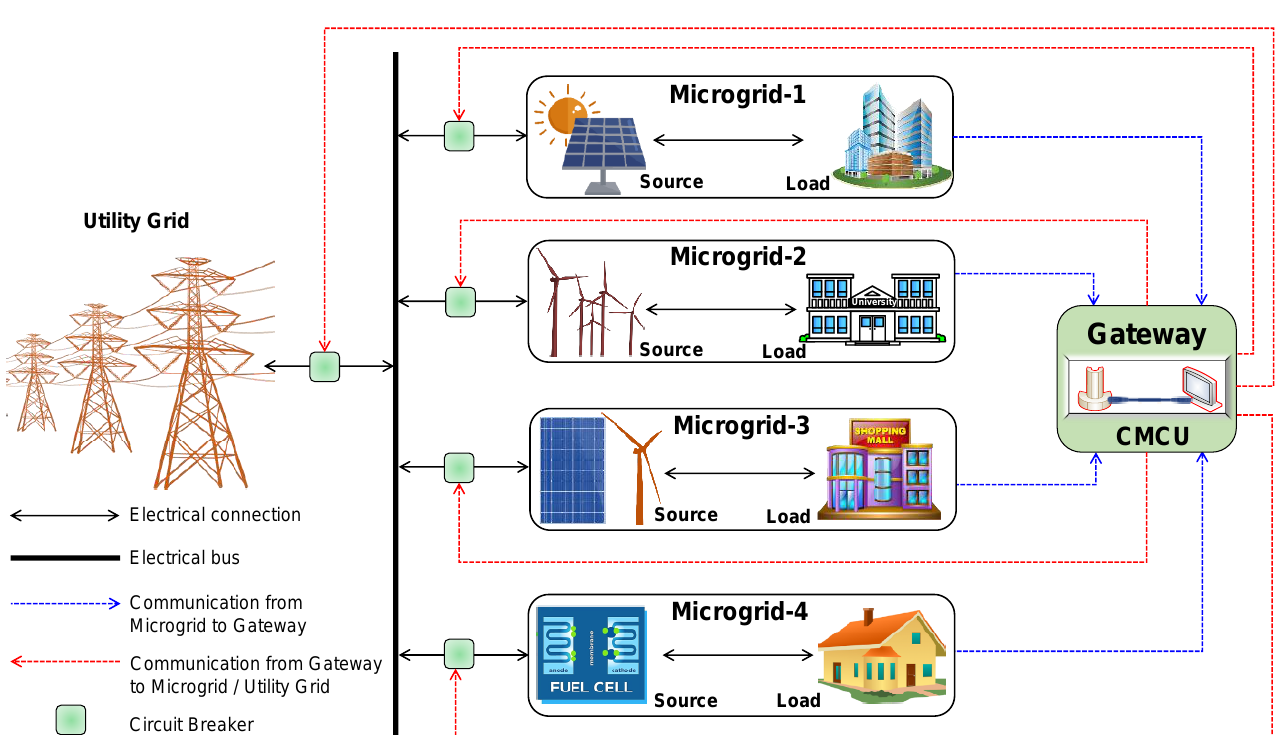
Figure 17. High-level view of ISM architecture.